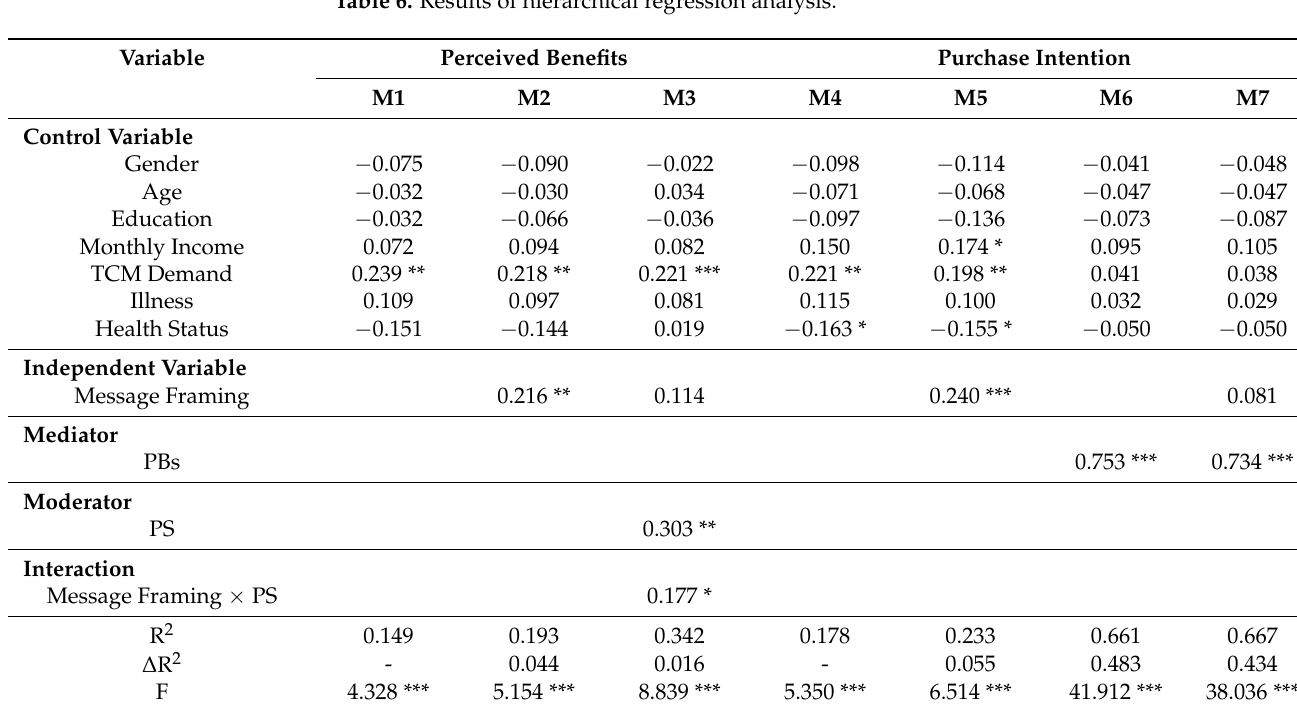
Table 7. Results of the test of moderated mediating effects.